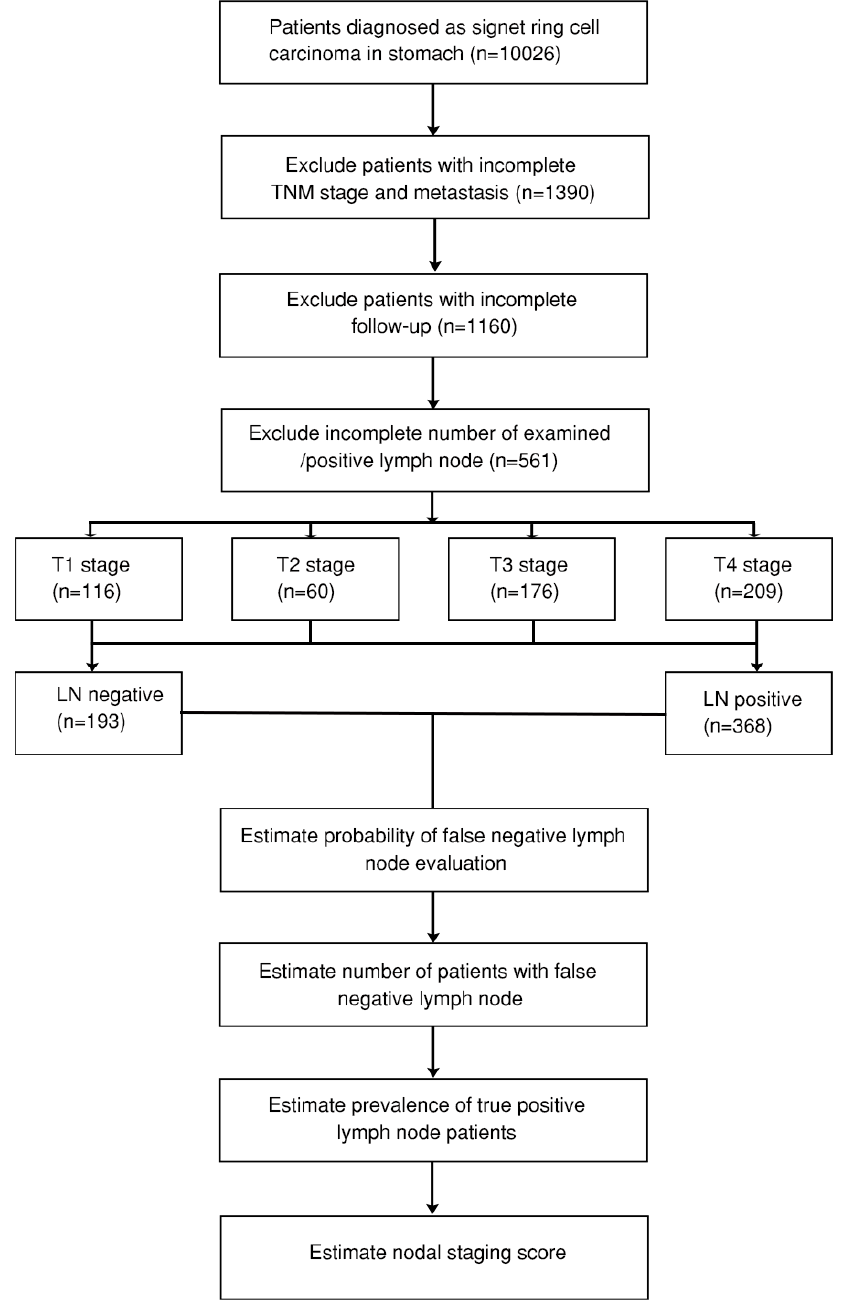
Figure 1. Consort diagram of gastric signet ring cell carcinoma (GSRCC) patients from the Surveil- lance, Epidemiology, and End Results (SEER) database. LN: lymph node; TNM stage: the American Joint Committee on Cancer (AJCC) TNM stage.